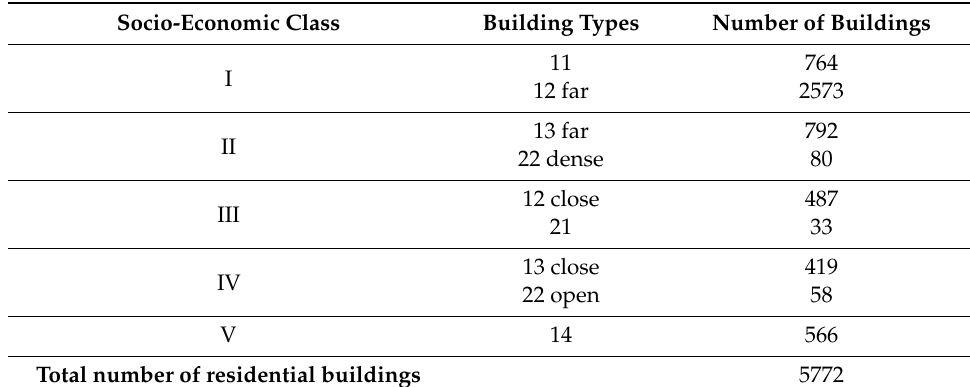
Table 7. Table on assignment of socio-economic classes to building types and number of buildings to corresponding building type classes and socio-economic classes.